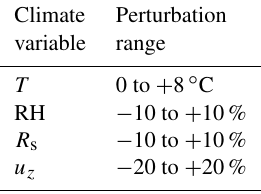
Table 2. Plausible perturbation bounds for each climate variable relative to their current